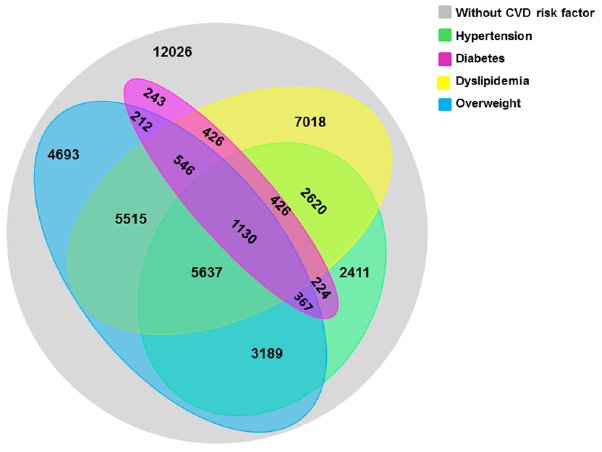
Figure 1. Distribution of four major CVD risk factors in the total sample. Grey represents the population with no defined CVD risk factors, and the other four colors represent the population with four different CVD risk factors. The numbers represent the number of individuals in the population with defined CVD risk factors in the respective